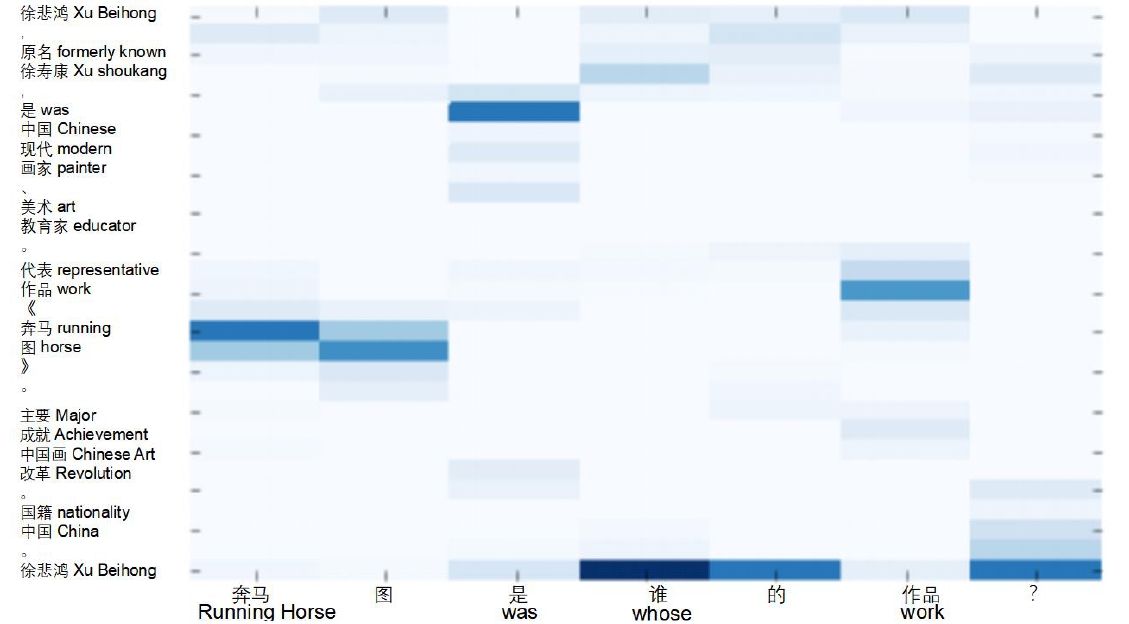
Figure 6. Final double attention distribution when NQGKG++ generated Q6.